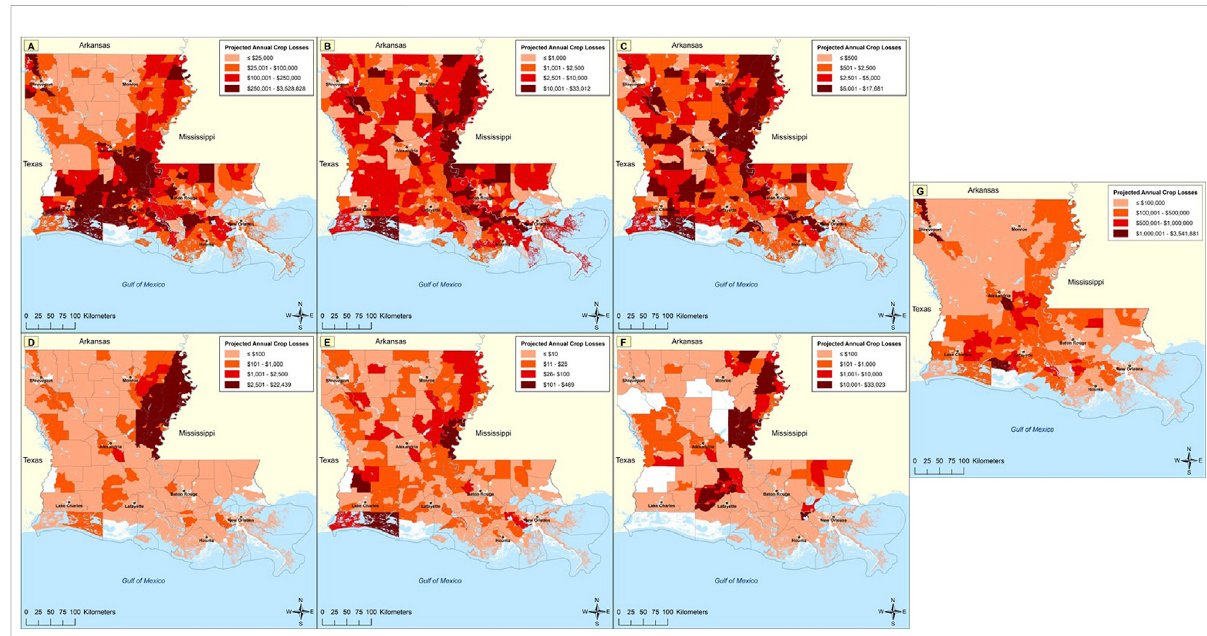
FIGURE 5 Projected annual crop loss (2019$) by Louisiana census tract, 2050: Drought (A) , extreme cold temperature (B) , extreme heat (C) , hail (D) , lightning (E) , tornado (F) , and total (G)